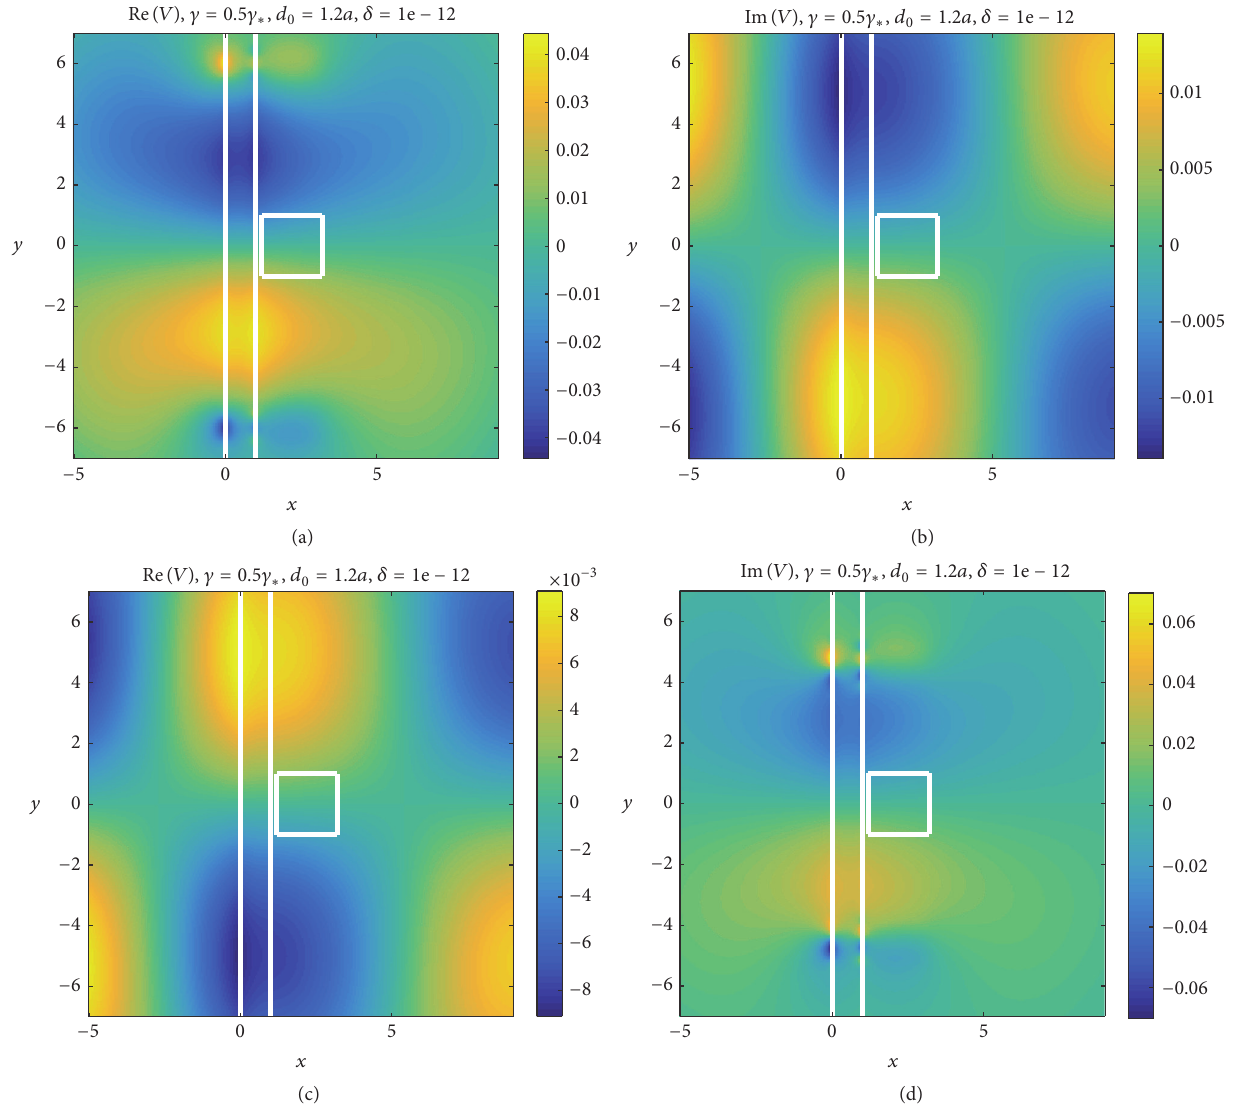
Figure 11: This is a plot of 𝑉 , the solution to (4), for two different sources with 𝑑 0 = 1.2𝑎 and 𝛾 = 0.5𝛾 ∗ : (a) Re (𝑉) and (b) Im (𝑉) for 𝑓 as in (70) (equivalently, (72)); (c) Re (𝑉) and (d) Im (𝑉) for 𝑓 as in (73) (equivalently